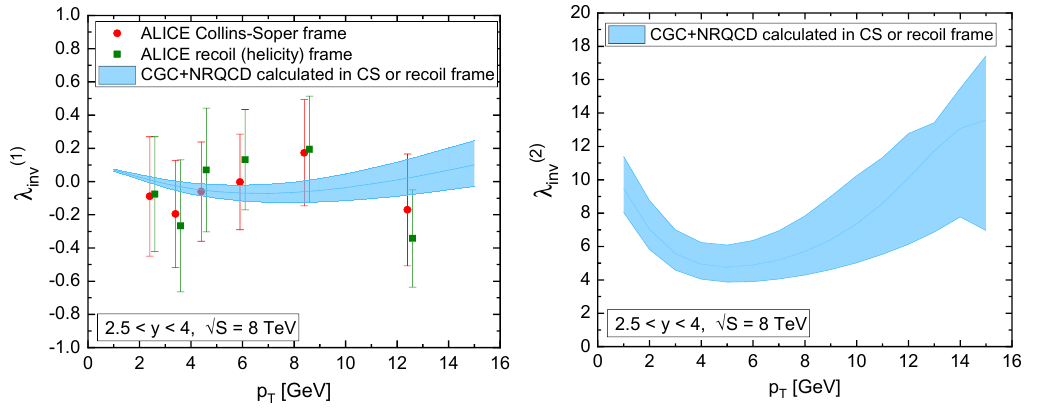
Figure 3 . The frame independent angular coe(cid:14)cients (cid:21) (1) functions of the J= ’s transverse momentum p T . The data are from the ALICE experiment at 8 TeV [15]. The experimental values of (cid:21) (1) (represented by red and green points respectively) coincide with each